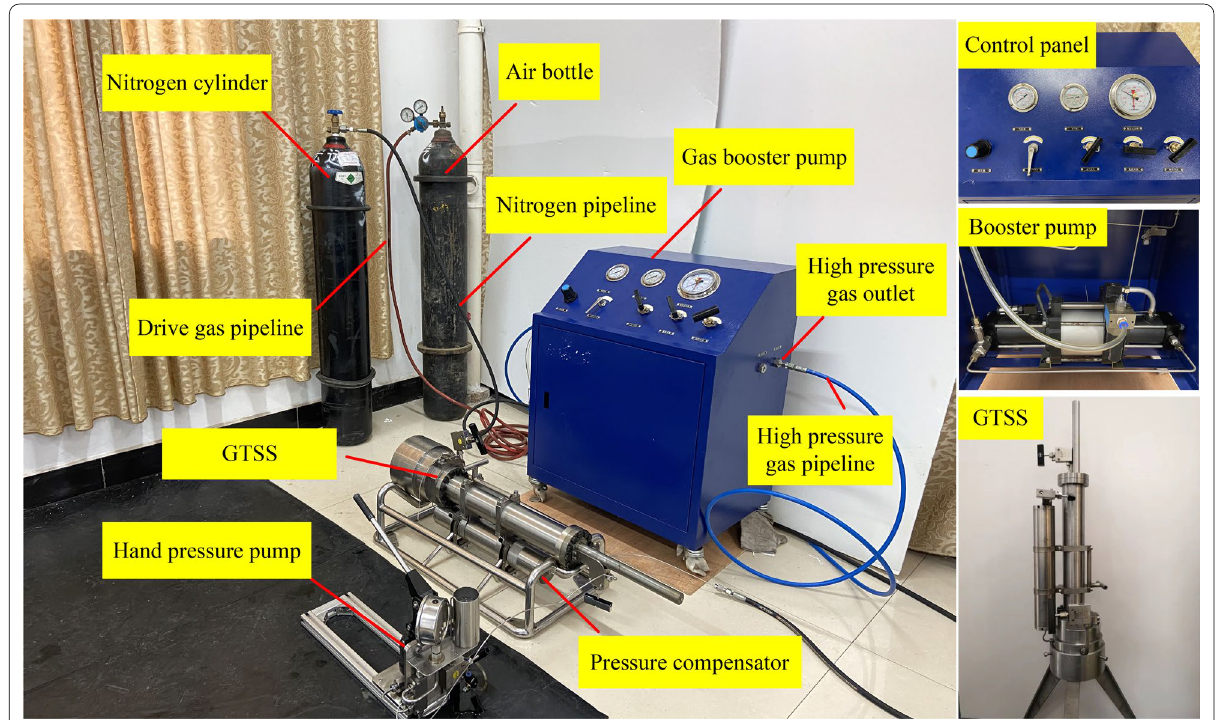
Figure 7 Air tightness test of GTSS